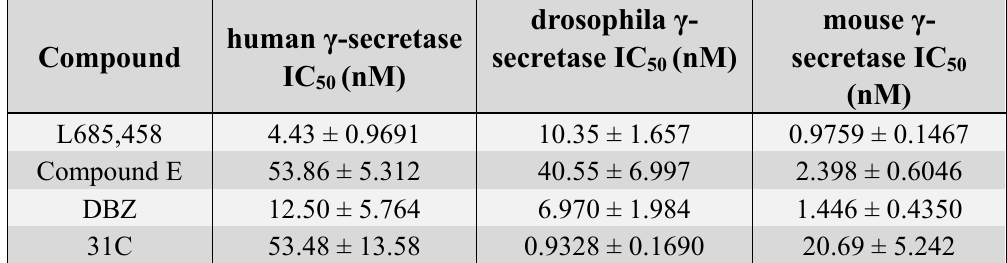
Table 2. Comparison of the IC drosophila and mouse γ